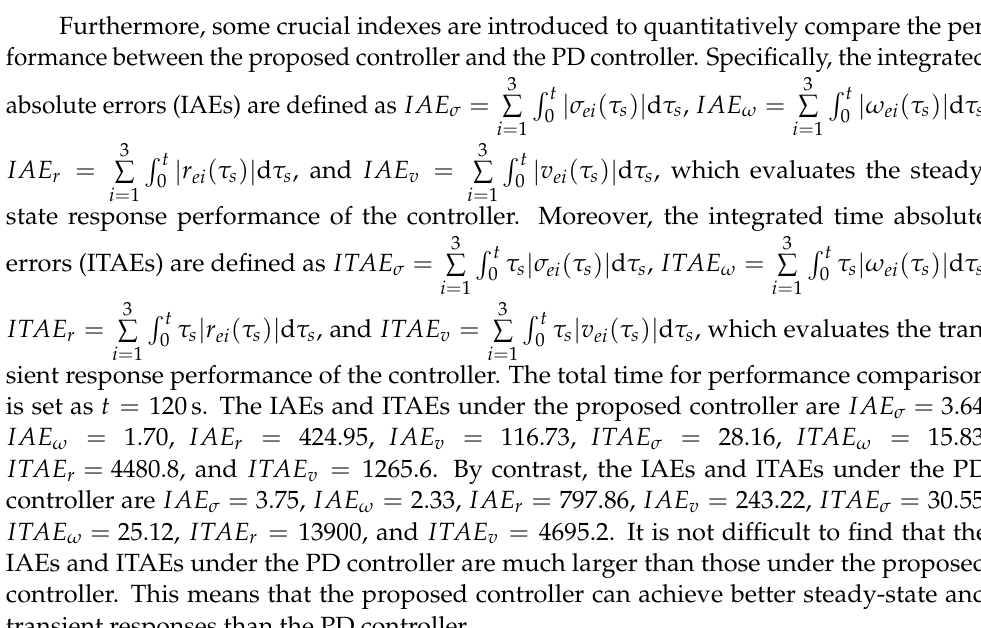
Figure 10. Control torques and forces of the chaser under the PD controller.